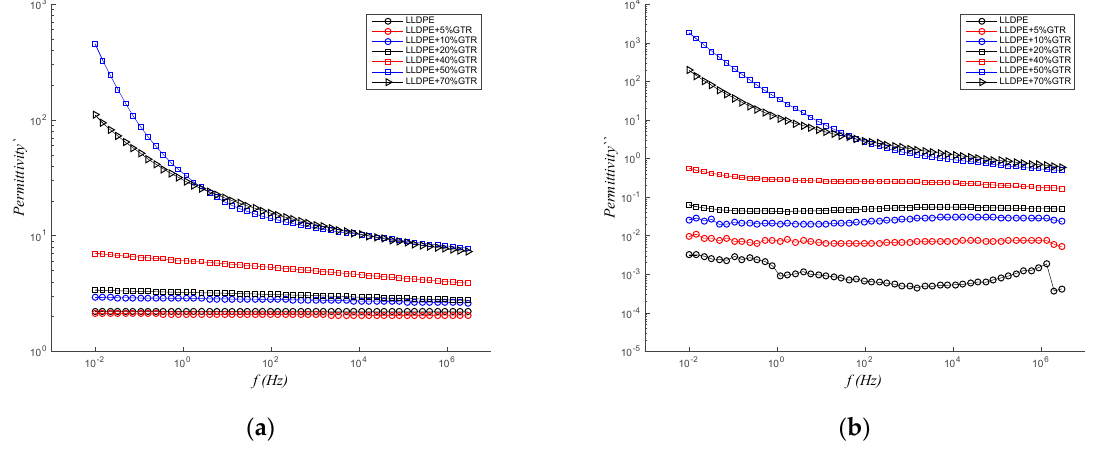
Figure 5. Compounds LLDPE / GTR, at 30 ◦ C in relation to frequency (From 10 − 2 to 3 × 10 6 Hz). ( a ) Real permittivity, ε ’, and ( b ) dielectric losses factor, ε ’’.